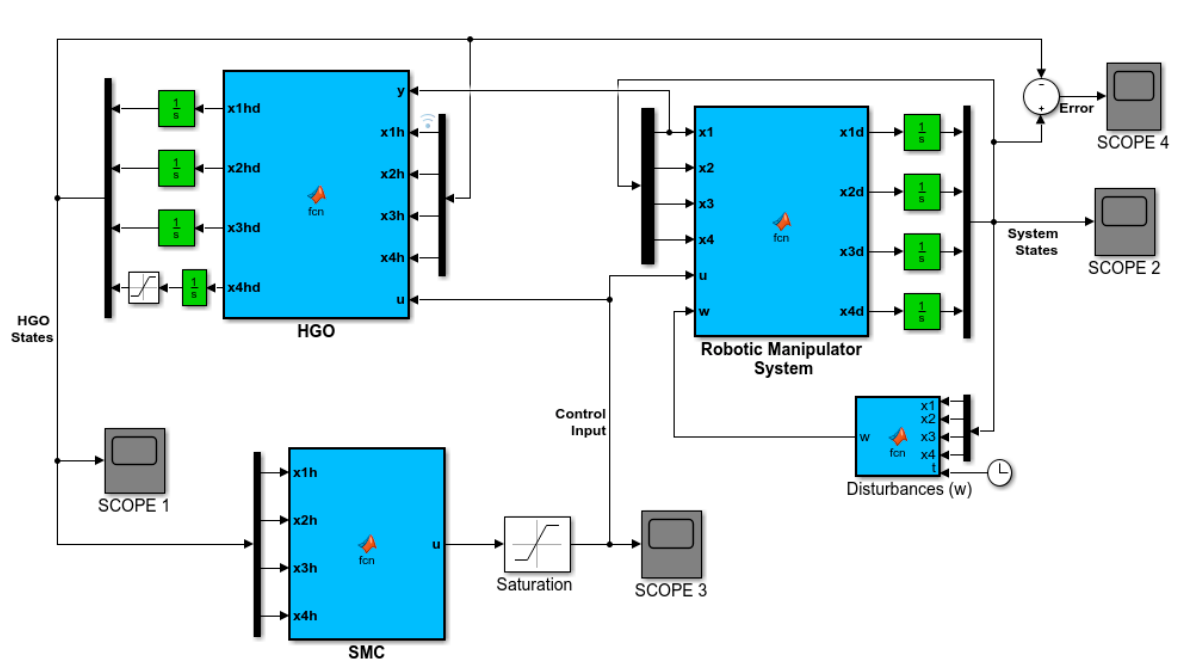
Figure 3. MATLAB/Simulink block diagram of the SFJRM with proposed output feedback controller in conjunction with HGO.